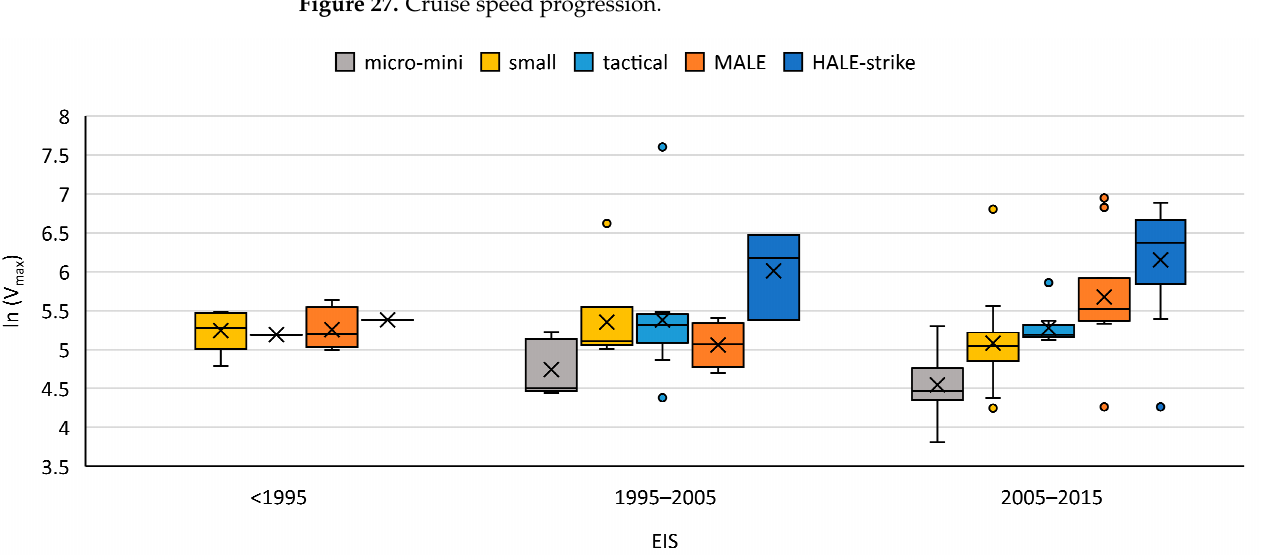
Figure 28. Maximum speed progression.